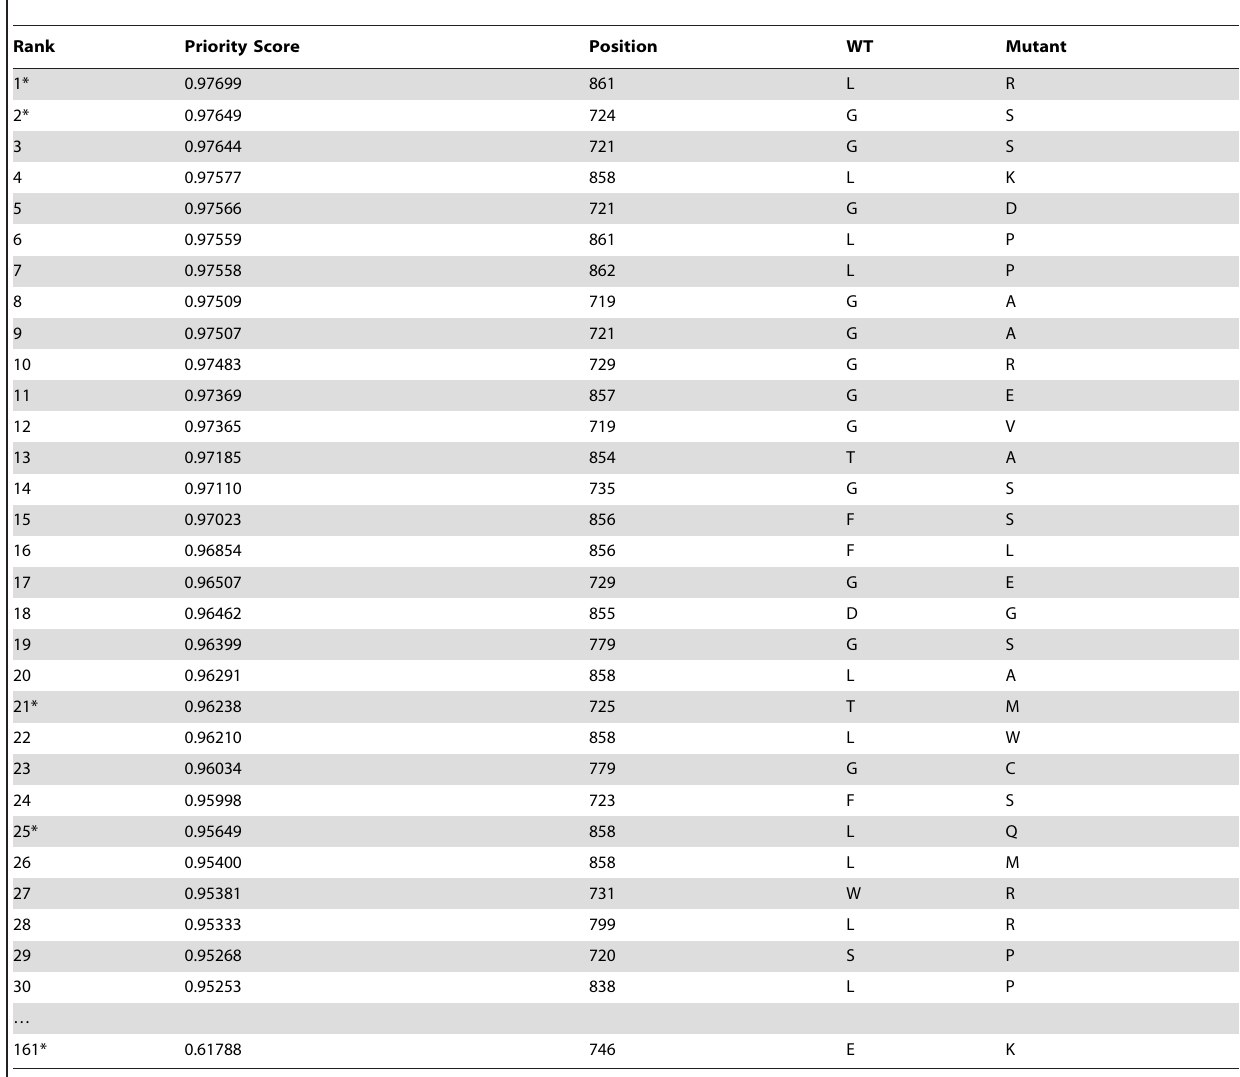
Table 4. Top predicted unconfirmed